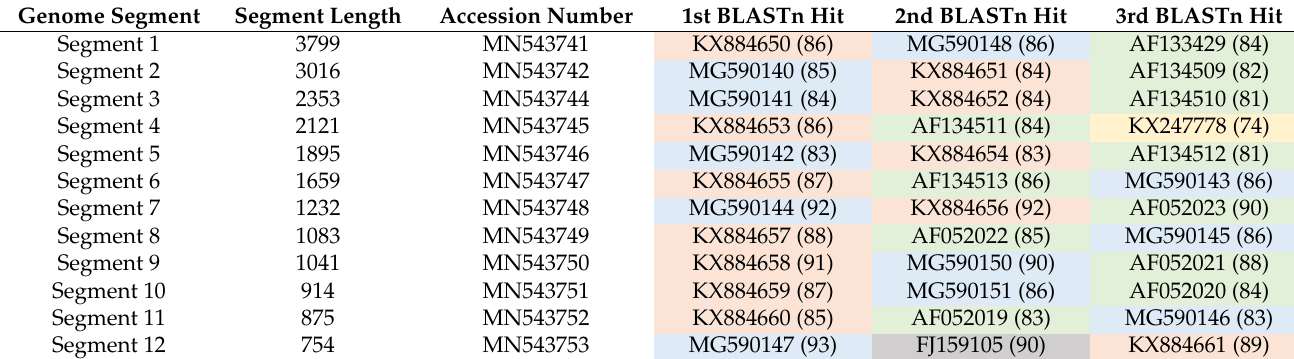
Assembled Kadipiro virus genome segments listed with the first three BLASTn search hits as acces- sion numbers, with percent identities in